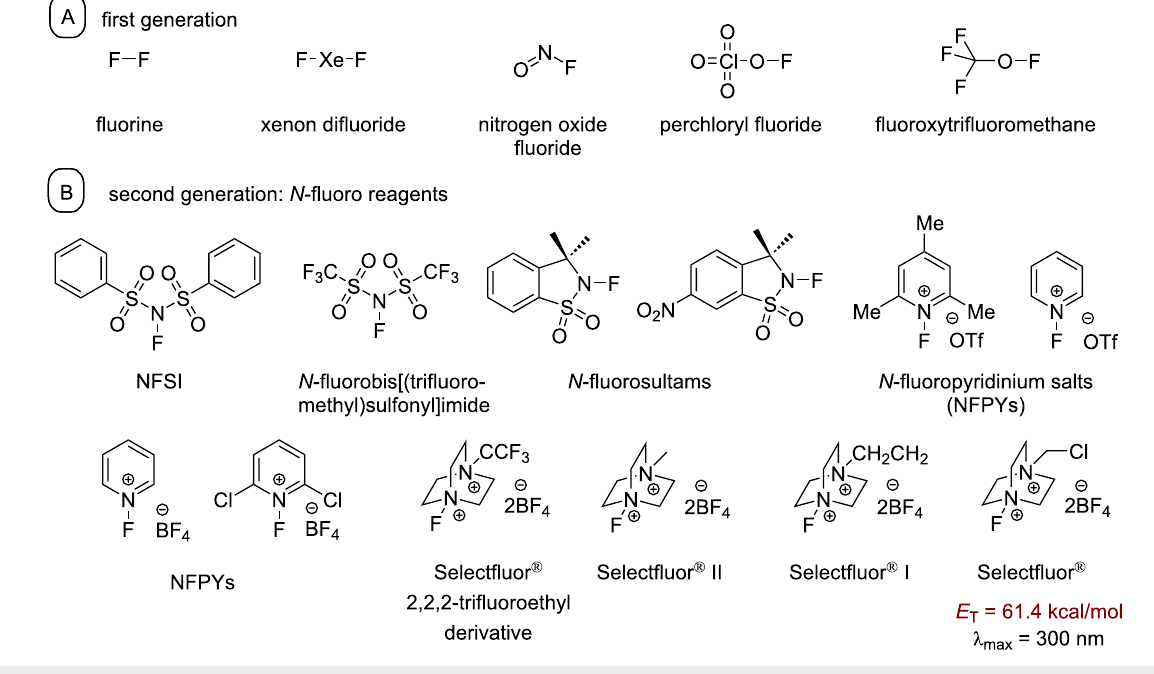
Figure 8: Different fluorination reagents grouped by generation.